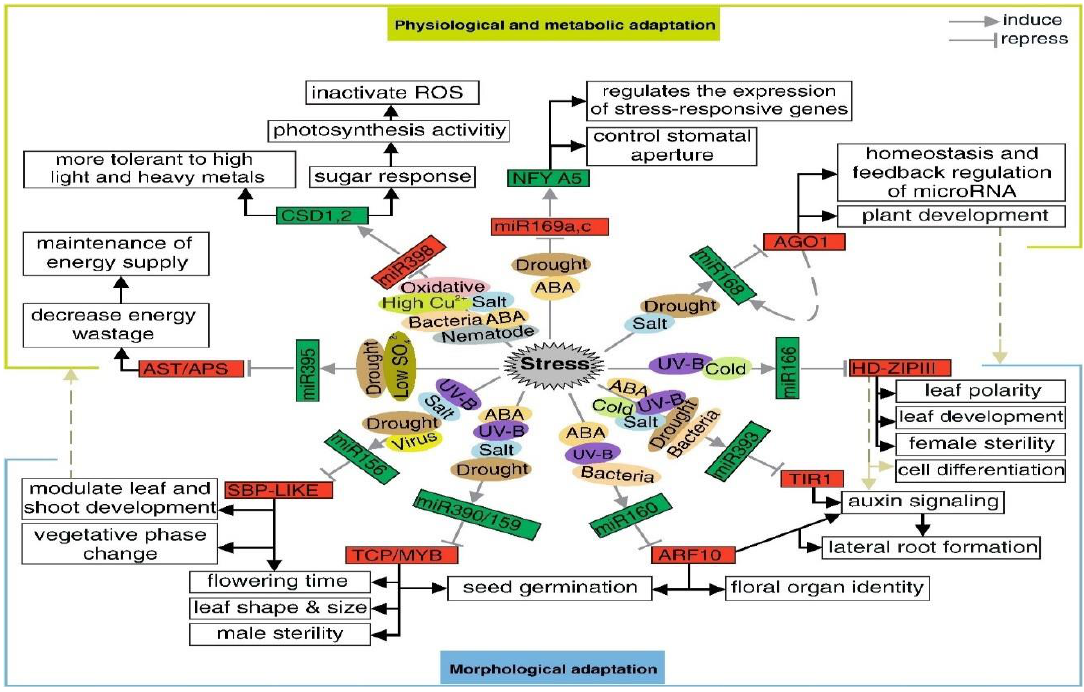
Figure 4. The regulatory mechanisms of miRNAs under abiotic stress conditions in Arabidopsis [32]. The proposed network defines the molecular mechanism of miRNA response to a variety of biotic and abiotic stresses. The network is based on expression profiles and targeted gene transcripts under stress condition.